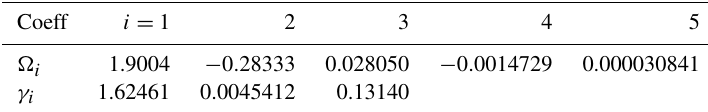
Table A3. Polynomial coefficients and rational function coefficients for psynth